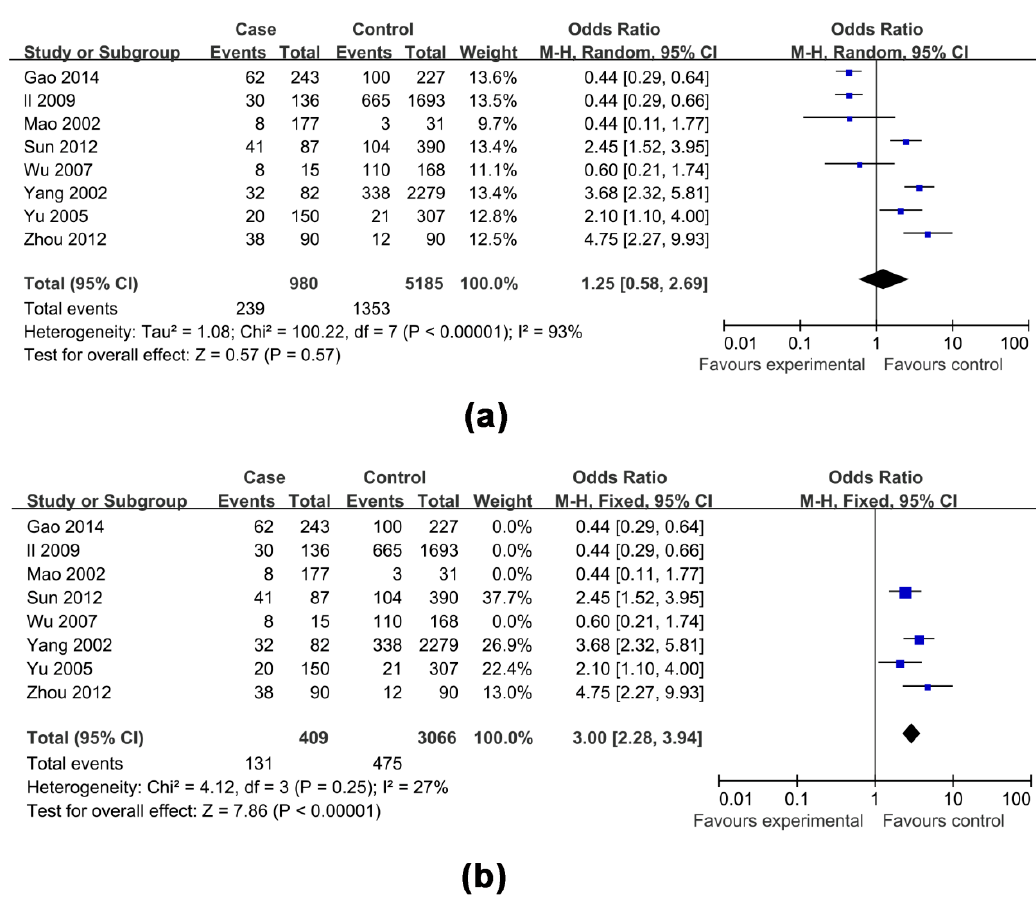
Figure 6. Effects of possible risk factors in chronic HBV-infected patients: ( a ) HBeAg positive; and ( b ) HBeAg positive adjusted.